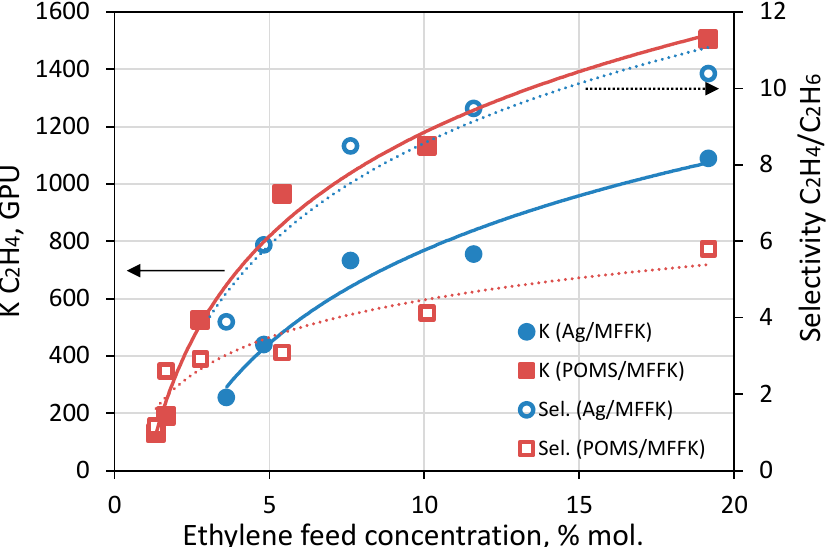
Figure 10. Dependence of the ethylene mass transfer coefficient (K, filled shapes) and ethylene/ethane selectivity (hollow shapes) on the initial ethylene concentration in the mixture for Ag9/MFFK (blue) and POMS/MFFK (red) composite membranes.